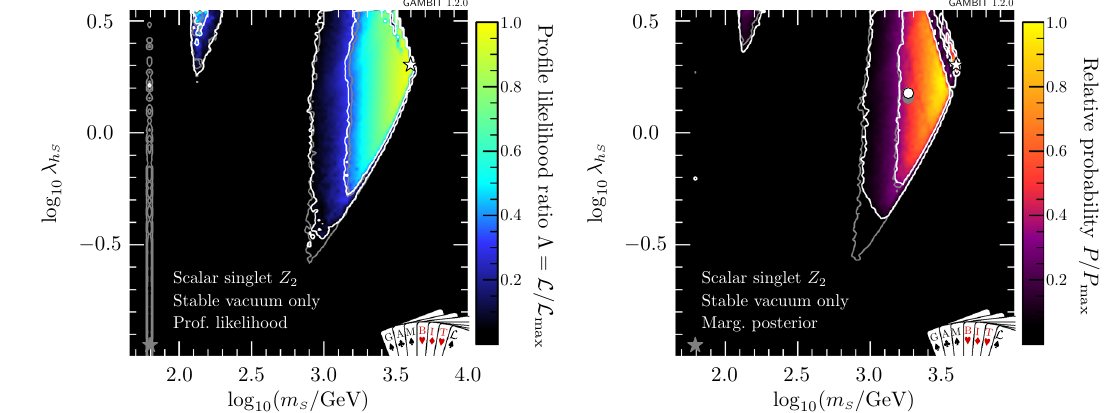
Fig. 4 Impact of the requirement of vacuum stability on the Z 2 scalar singlet model, expressed in terms of profile likelihoods (left) and pos- terior probability densities (right). Bullets indicate posterior means and stars indicate best fit points. Shading and white annotations correspond